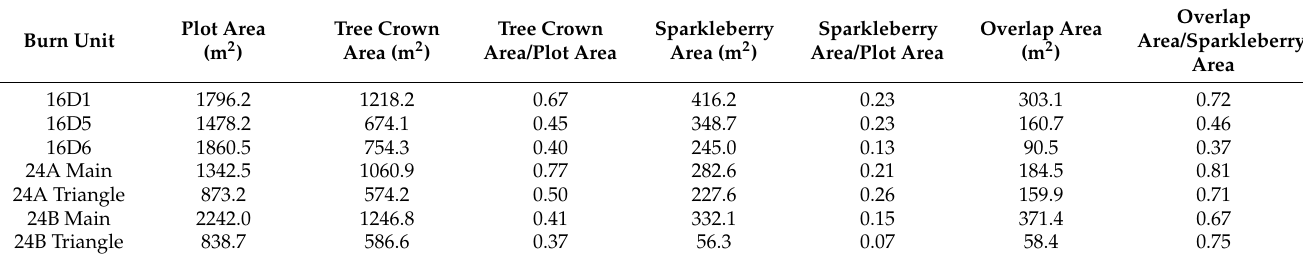
Table 1. Area estimated from digitized sparkleberry shapefiles and tree crown shapefiles for each burn unit.